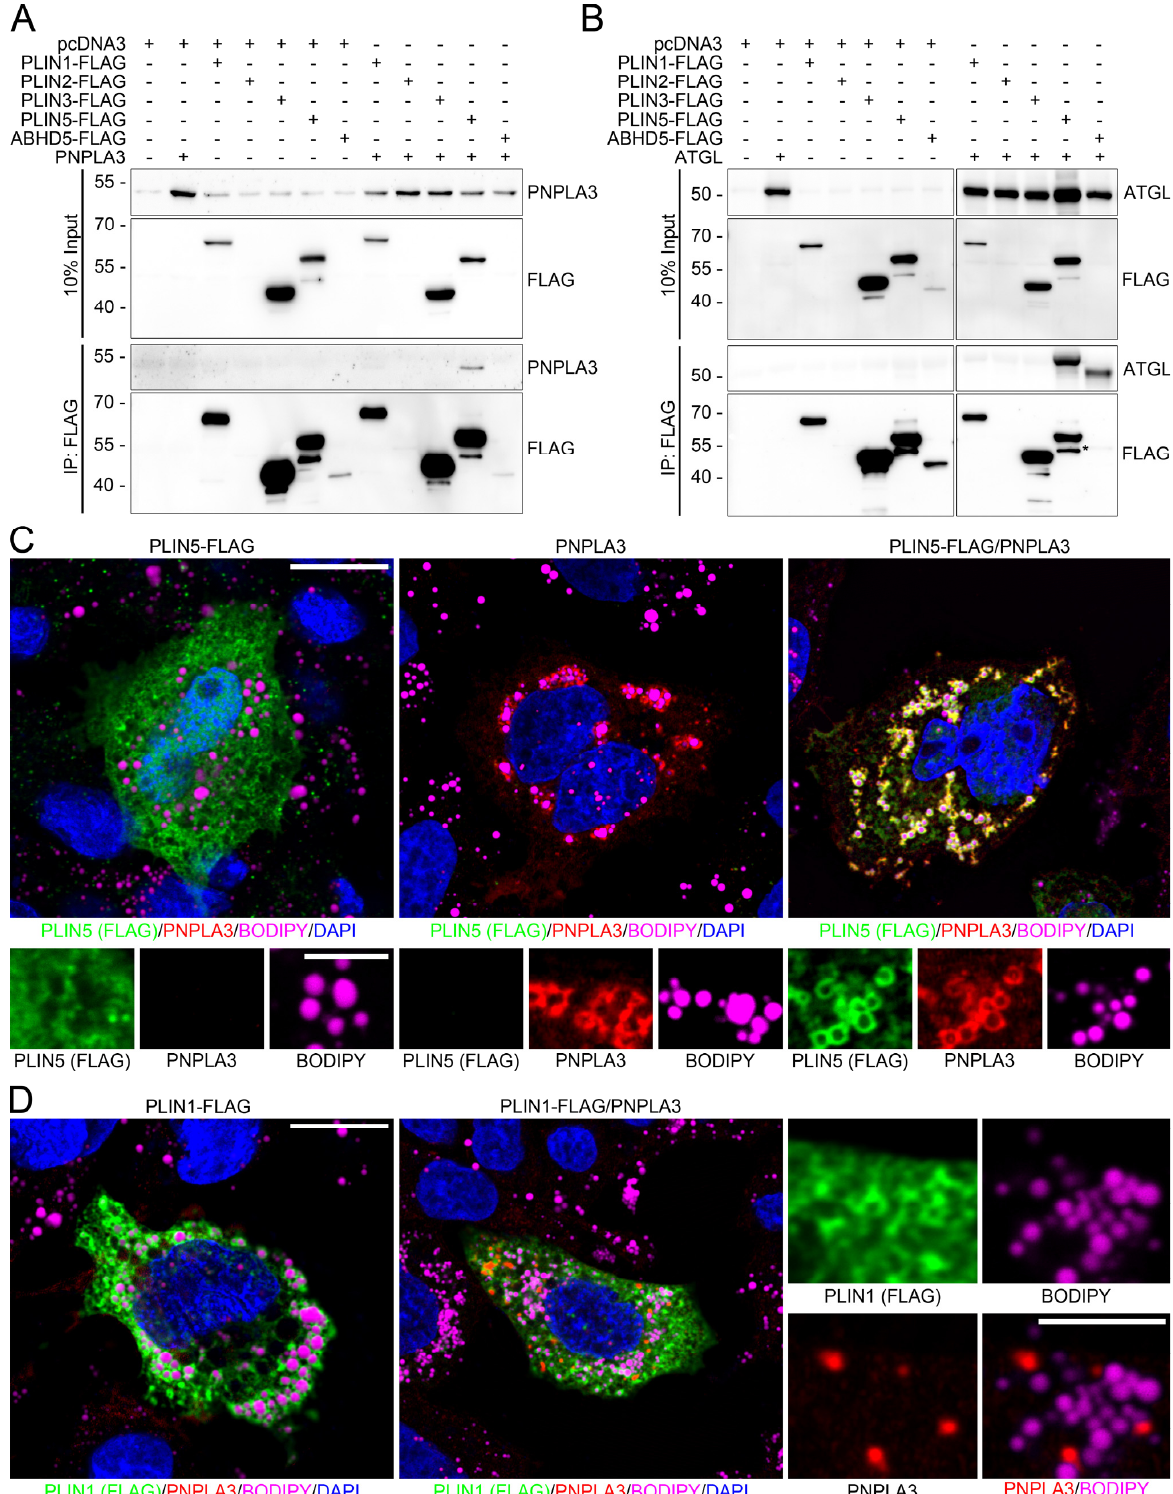
Figure 3. Opposing effects of perilipin 1 and 5 on the recruitment of PNPLA3 to LDs. ( A , B ) Immunoblot analysis of PNPLA3 in co-immunoprecipitates of FLAG-tag in HEK293T cells transfected with PNPLA3 or ATGL alone or together with FLAG-tagged PLIN1, 2, 3, 5 or ABHD5. PNPLA3 co-immunoprecipitates only with perilipin 5 (PLIN5), but not with other perilipins,